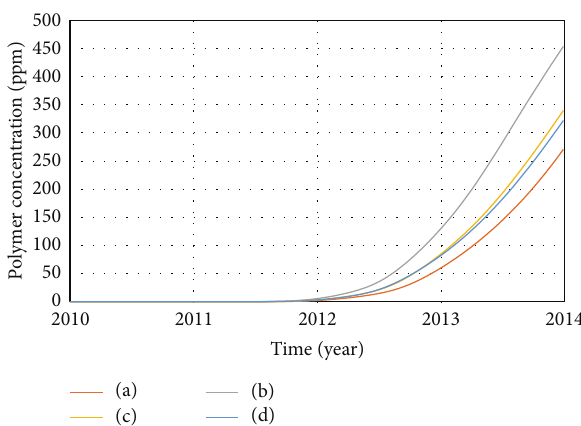
Figure 10: Calculated polymer concentration at producer from using four different matching functions: (a) constant RRF, (b) RRF = 𝑎/𝑘 2 + 1, (c) RRF = 𝑎 1 /𝑘 2 + 𝐶 M . Trap + 1, and (d) RRF = 𝑎 1 /𝑘 2 + 𝐶 M . Trap + 1 (𝑘 ≤ 0 . 45 𝑒 − 12 m − 2 ) or = 𝑎 2 /𝑘 2 + 1 (𝑘 > 0 . 45 𝑒 − 12 m − 2 )